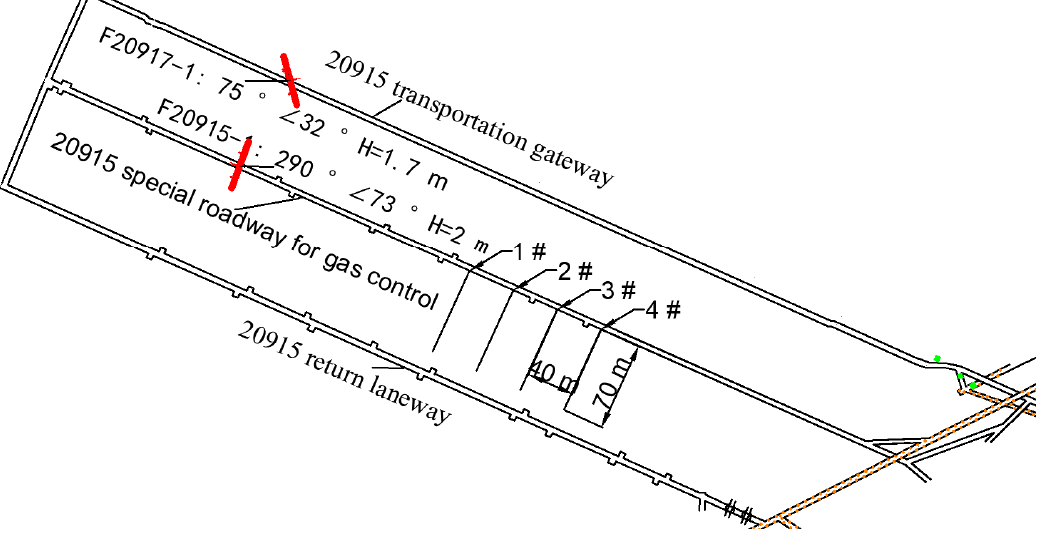
Figure 16. Borehole layout.